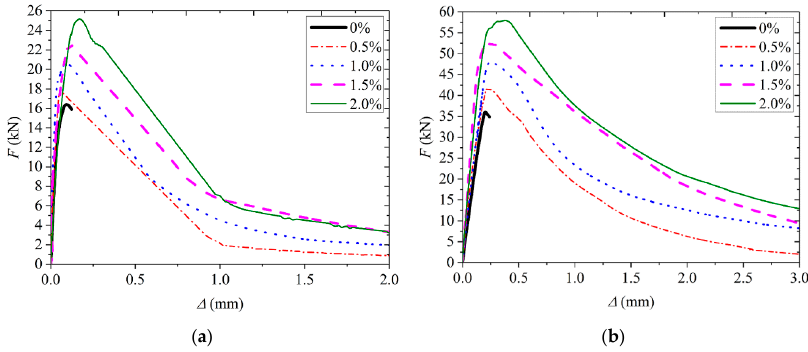
Figure 12. F - Δ curve: ( a ) Type A ARGF-CAC; and, ( b ) Type B ARGF-CAC. Figure 12. F - ∆ curve: ( a ) Type A ARGF-CAC; and, ( b ) Type B ARGF-CAC.